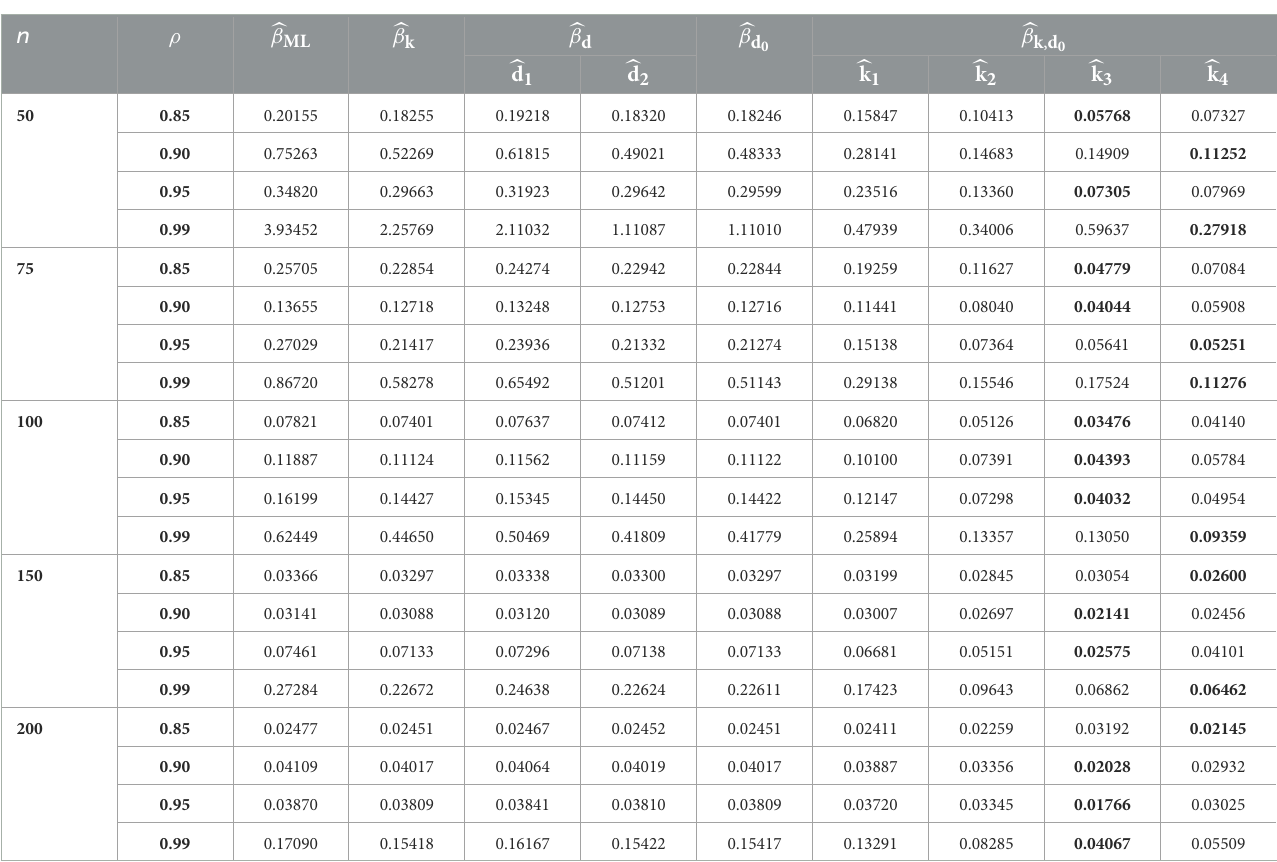
TABLE 8 MSE values in case of p = 9 and γ =